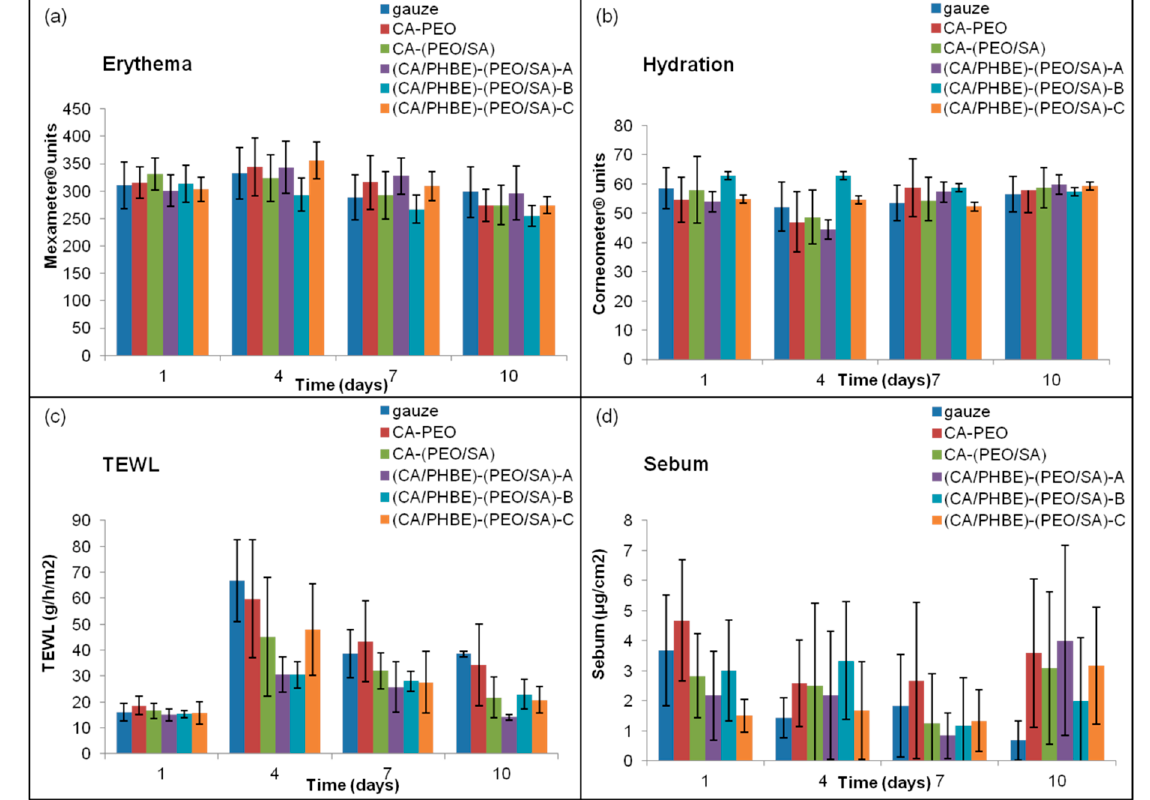
Figure 3. Histograms of ( a ) erythema, ( b ) hydration, ( c ) TEWL and ( d ) sebum production in relation to time after UV exposure.